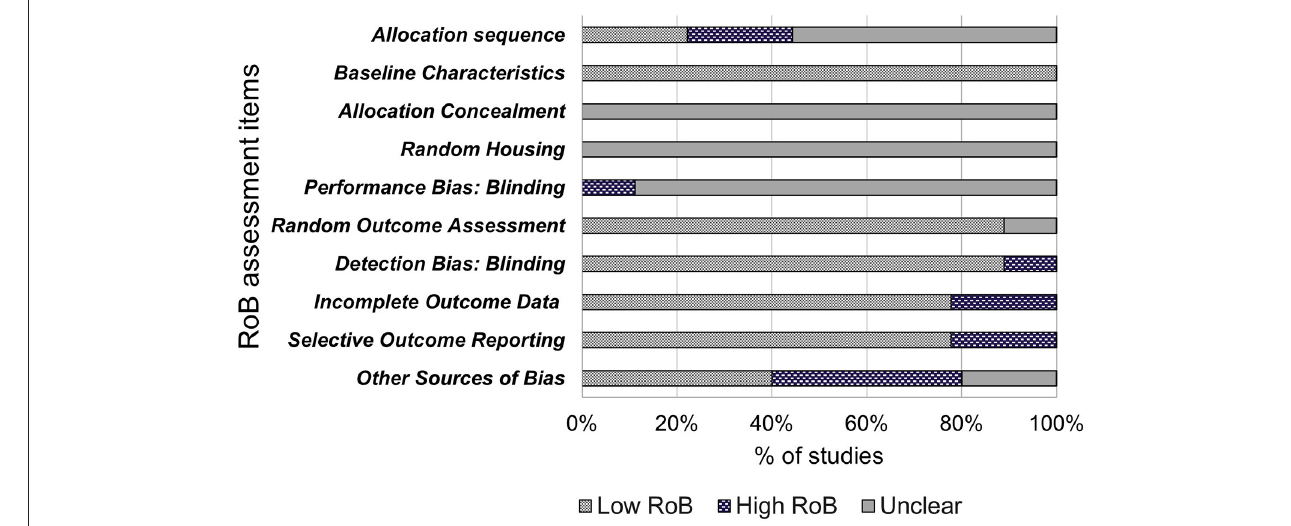
FIGURE 2 | Risk of